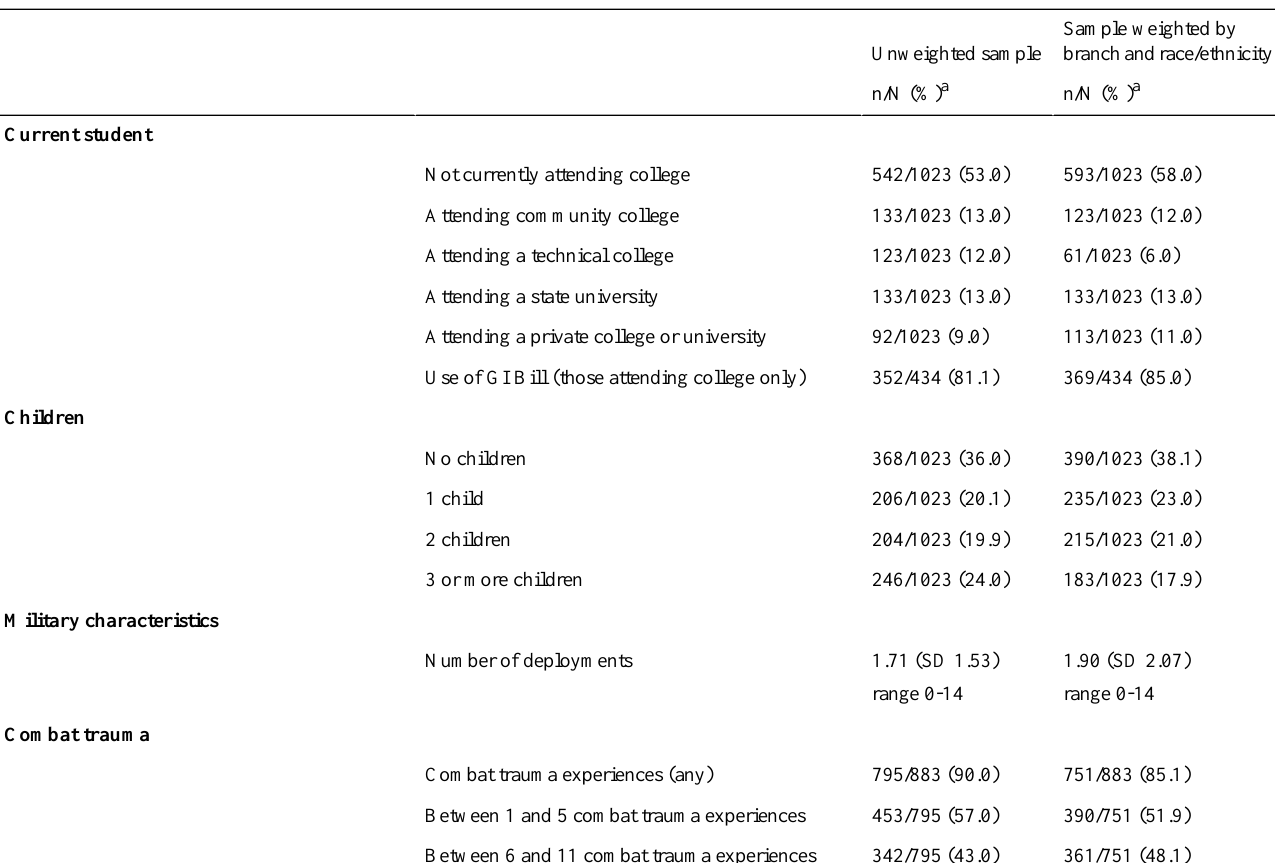
Table 3. Other demographics including whether the participants are current students, number of children, military characteristics, and combat severity status of the unweighted Facebook sample and the Facebook sample weighted by branch and